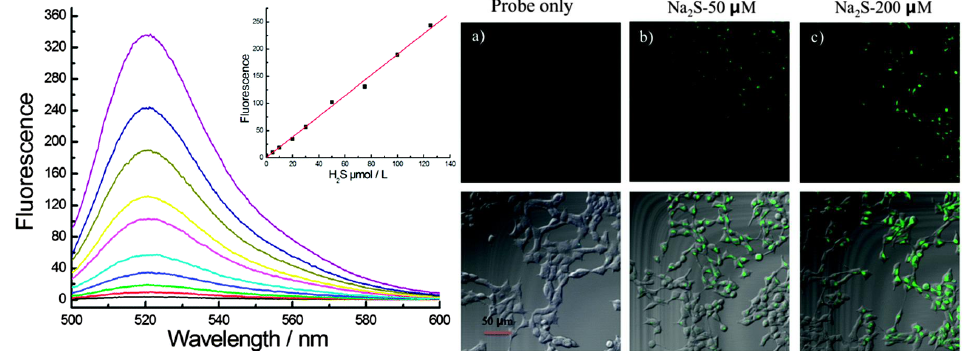
Figure 11. Biological sensing of hydrogen sulfide of dye 29 [41]. Fluorescence spectra ( left ) of 1 µM of dye 29 at concentrations 0 – 125 µM of hydrogen sulfide. Inset indicates a linear relationship between fluorescence and increasing concentrations of hydrogen sulfide. Confocal microscopy ( right ) of HEK293A cells incubated in 1 µM of dye 29 and two concentrations of sodium sulfide, 50 µM and 200 µM, respectively. Top images show fluorescence without the aid of a bight field. Scale bar: 50 µm. Figure used with permission from [41]. Copyright 2015 Royal Society of Chemistry.